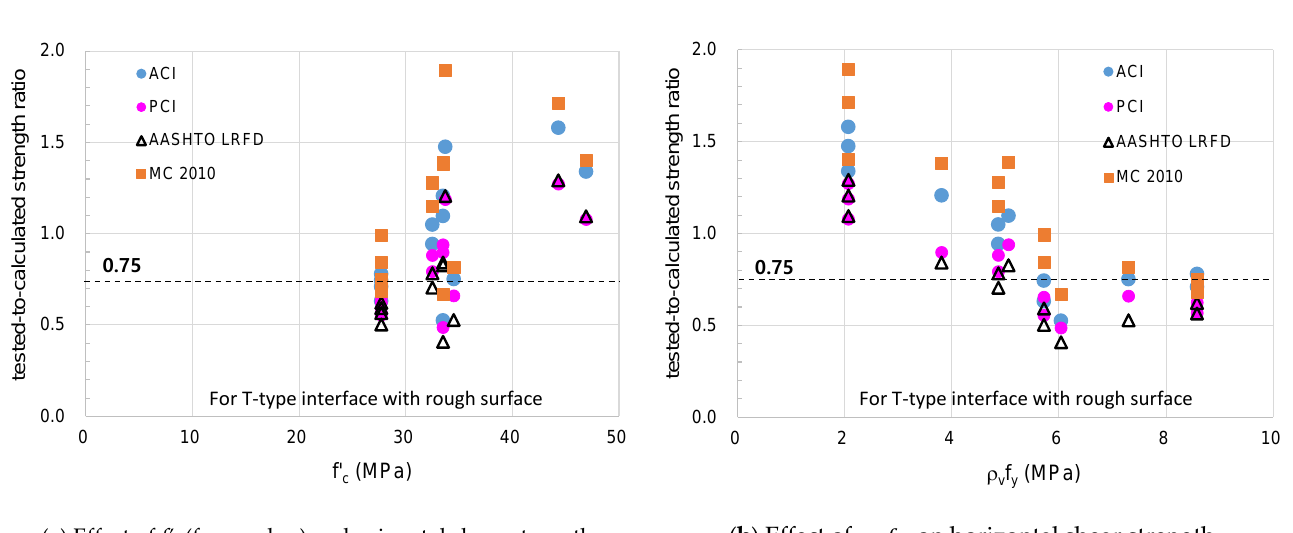
Figure 12 . T-type interface with roughened surface for beam specimens. Figure 12. T-type interface with roughened surface for beam specimens. However, MC 2010 gives a relatively safe estimation of the horizontal shear strength for specimens with T-type interface in case of Case 2 category. It is considered that MC 2010 specifies the friction factor of 0.7 to reflect the contribution of shear friction by shear connector. On the other hand, ACI code with a friction factor of 1.0 produced a minimum strength ratio of 0.53. However, if a friction factor of 0.7 is applied for ACI prediction for T-type interface in shear friction design category, all strength ratios can rise above a strength reduction factor of 0.75. Therefore, it is recommended that the friction factor of 0.7 is used in order to reflect the deterioration of horizontal shear performance for T-type